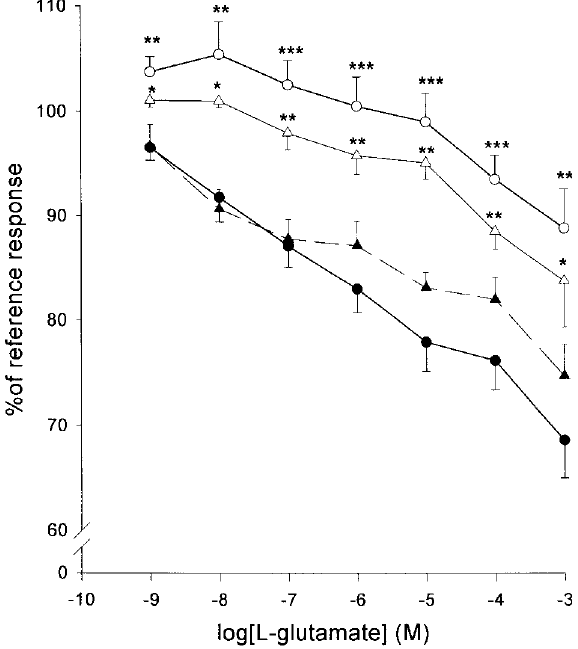
FIG. 6. The effect of NMDA in the presence of 10 –6 M kainic acid ( m ), of kainic acid in the presence of 10 –6 M NMDA ( j ), and in magnesium-free medium ( s ). The responses are mean ±SE ( n = 6) and are plotted as a percentage of the reference response before the exposure to agonists. * p < 0.05, ** p < 0.01, *** p < 0.001 paired t